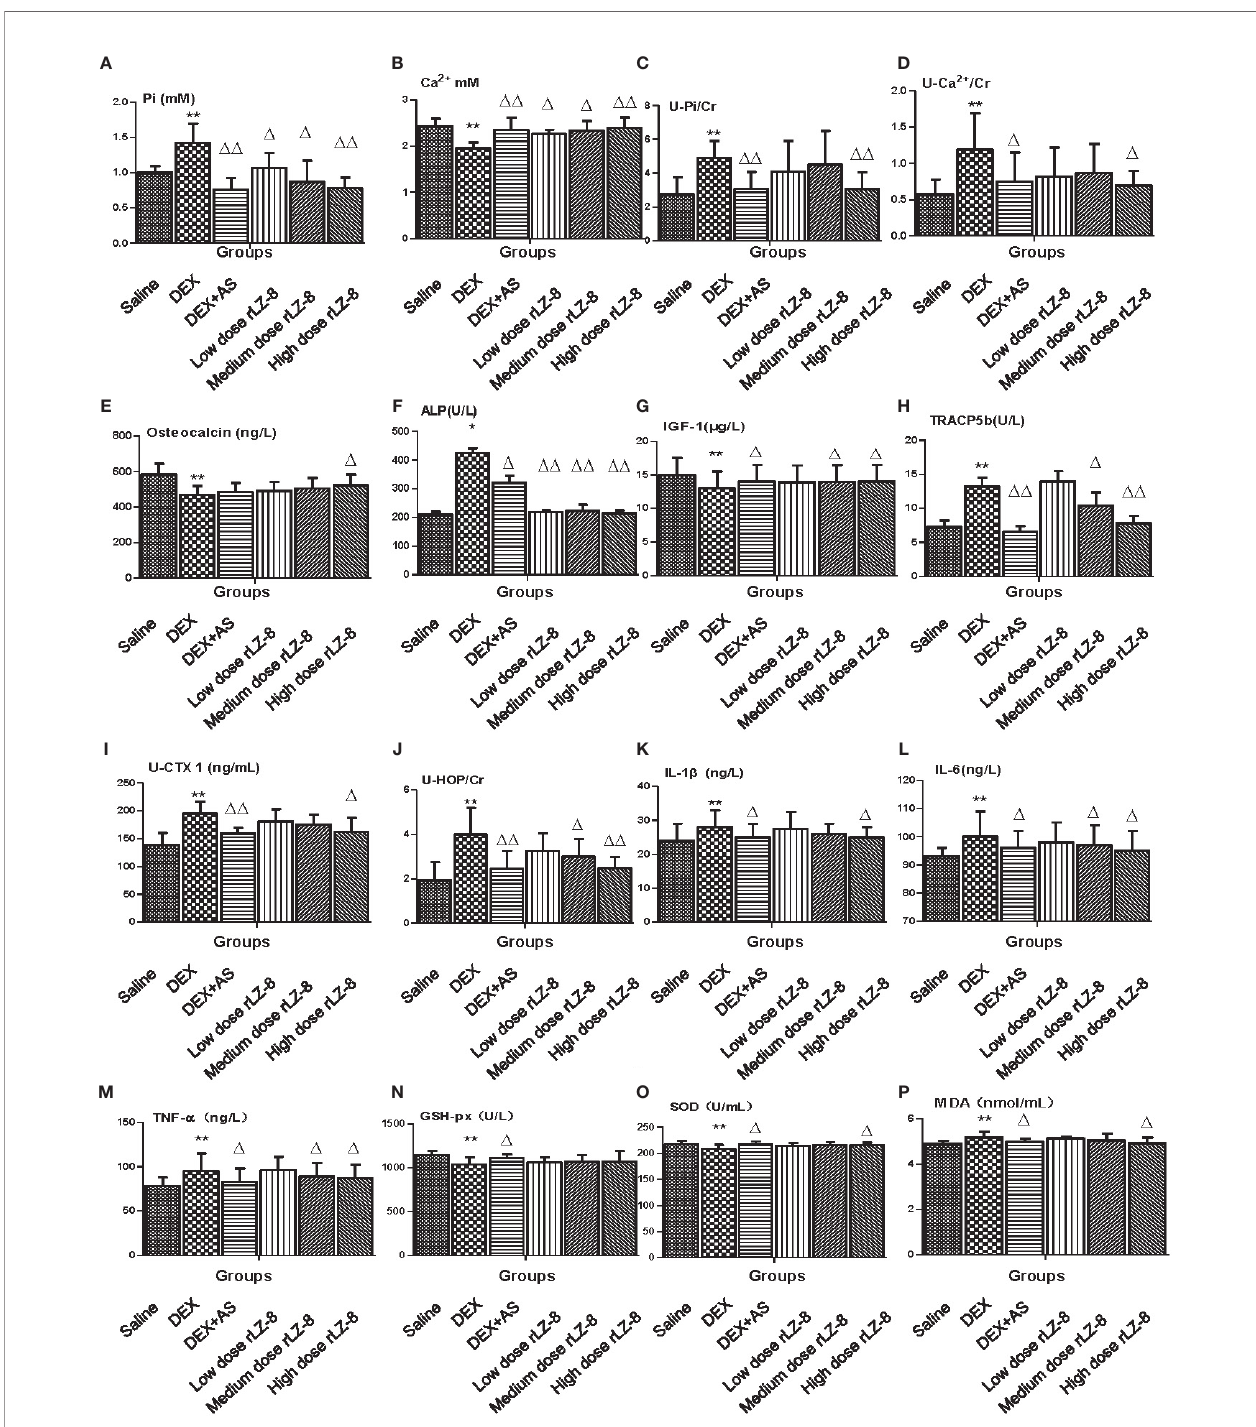
FIGURE 5 | Effect of rLZ-8 on level of bone metabolic markers in GIOP rat ’ s serum and urine. (A) Serum phosphorus (mM); (B) Serum calcium (mM); (C) Urinary phosphorus/Cr (mM/mg); (D) Urinary calcium/Cr (mM/mg); (E) Serum osteocalcin (ng/L); (F) Serum ALP (U/L); (G) Serum IGF-1 ( m g/L); (H) Serum TRACP5b (U/L); (I) Urinary CTX1/Cr (ng/mL * mg); (J) Urinary HOP/Cr (mM/mg); (K) IL-1 b (ng/L); (L) IL-6 (ng/L); (M) TNF- a (ng/L); (N) GSH-px (U/L); (O) SOD (U/mL); (P) MDA (nmol/ L). Compared with the blank control group, * stands for P < 0.05 and ** stands for P < 0.01; Compared with the model group, △ stands for P < 0.05 and △△ stands for P <